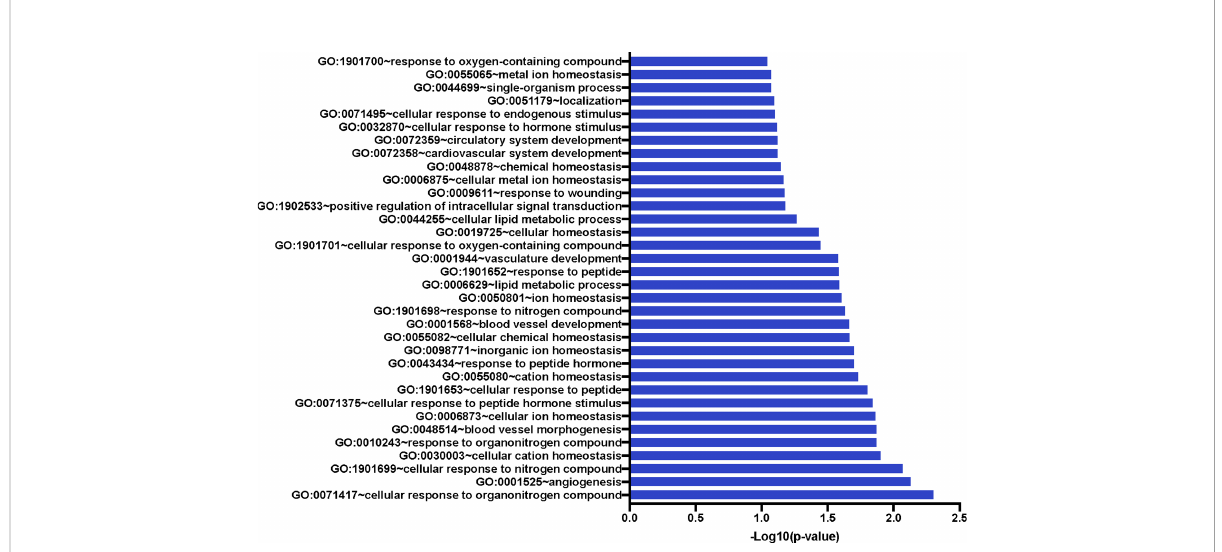
FIGURE 3 Signi fi cant Gene Ontology populated by the 41 genes of interest. The 41 GOIs were used to query DAVID Bioinformatics Resource v 6.8 (https://david. ncifcrf.gov/). We identi fi ed numerous GO terms as statistically signi fi cant; these included response or cellular response to nitrogen or organonitrogen, as well as response to cellular ion and cation homeostasis. Blood vessel development and morphogenesis terms were also